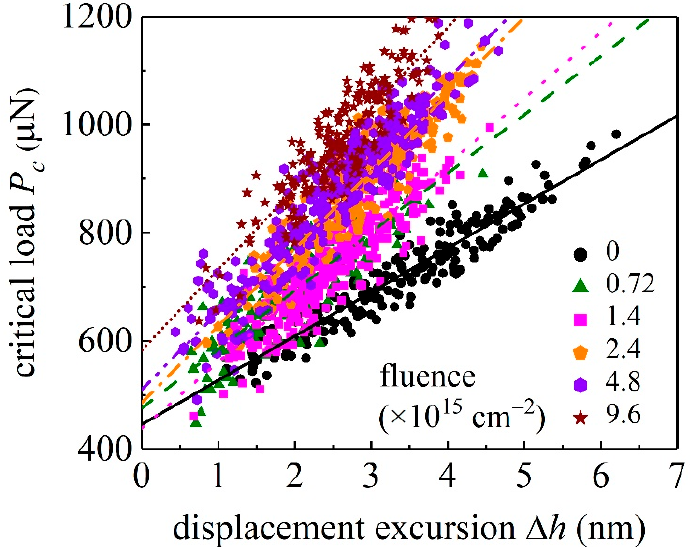
Figure 5. The critical load for pop ‐ in versus the corresponding displacement excursion for unirradiated and irradiated GaN samples. Straight lines are linear fits to experimental pop ‐ in data (symbols).